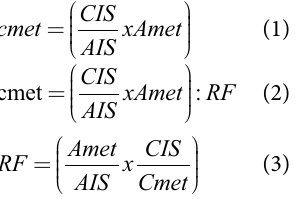
( Supplementary Figure S-6 ). The heatmap of protein and metabolite concentrations with rows and columns ordered based on unsupervised clustering of the analytes (Pearson correlation-based distance, main clusters A, B, C) and the DBS samples (Euclidean distance, main clusters D, E) is shown in Supplementary Figure S-4